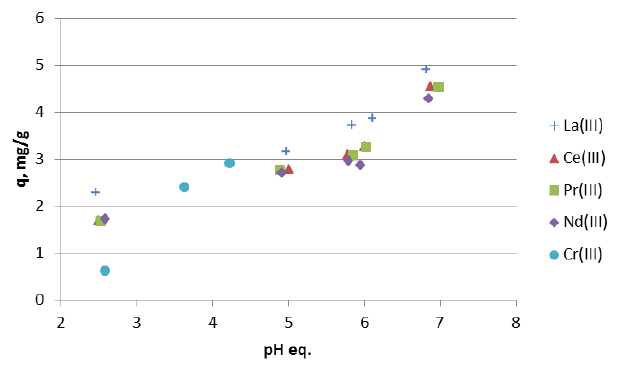
Figure 3. The effect of equilibrium pH on the sorption capacities of lanthanides and chromium ions. The initial concentration of metal ions was 100 mg/L.